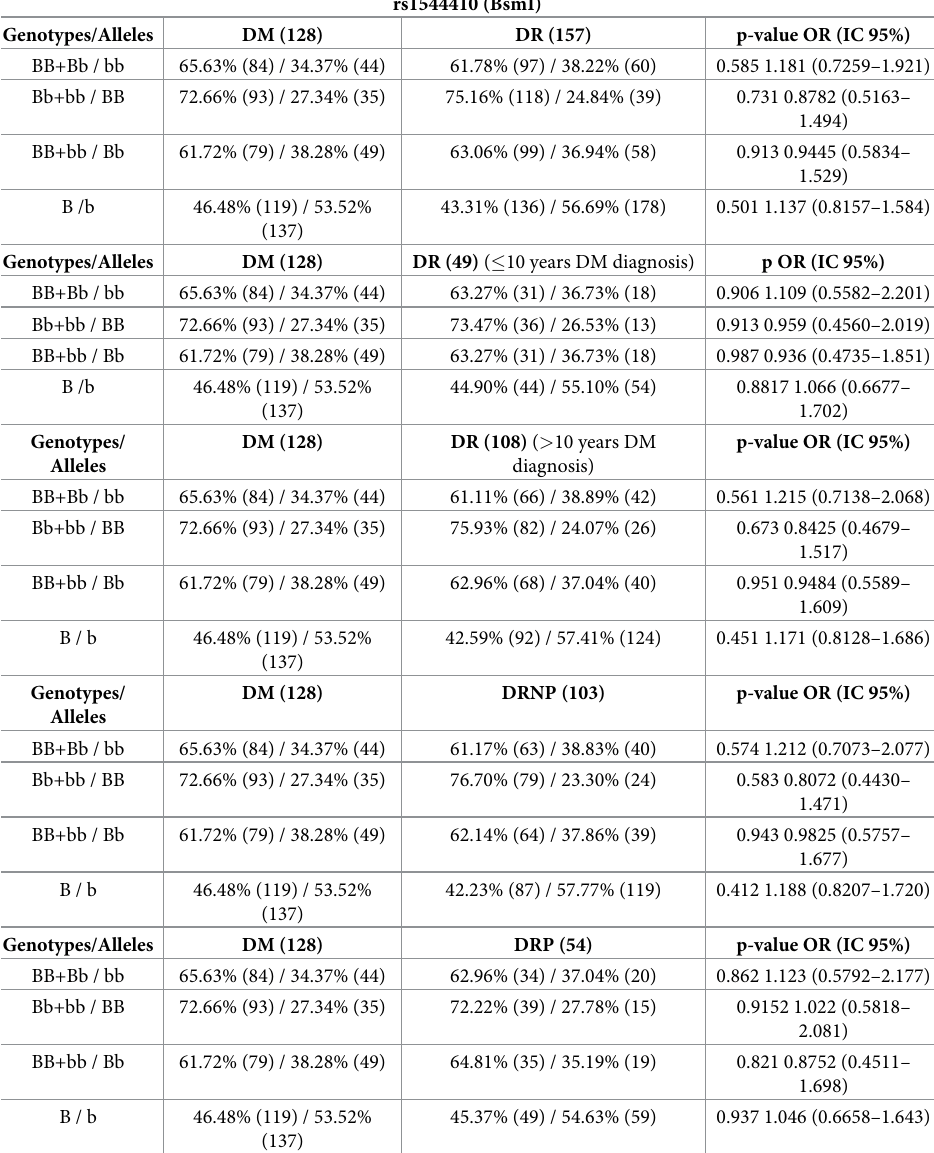
Table 2. Genotypic and allelic distribution of the polymorphism rs1544410 among type 2 diabetic patients with- out DR and RD, < 10 years DM diagnostic, � 10 years DM diagnostic, RDNP and